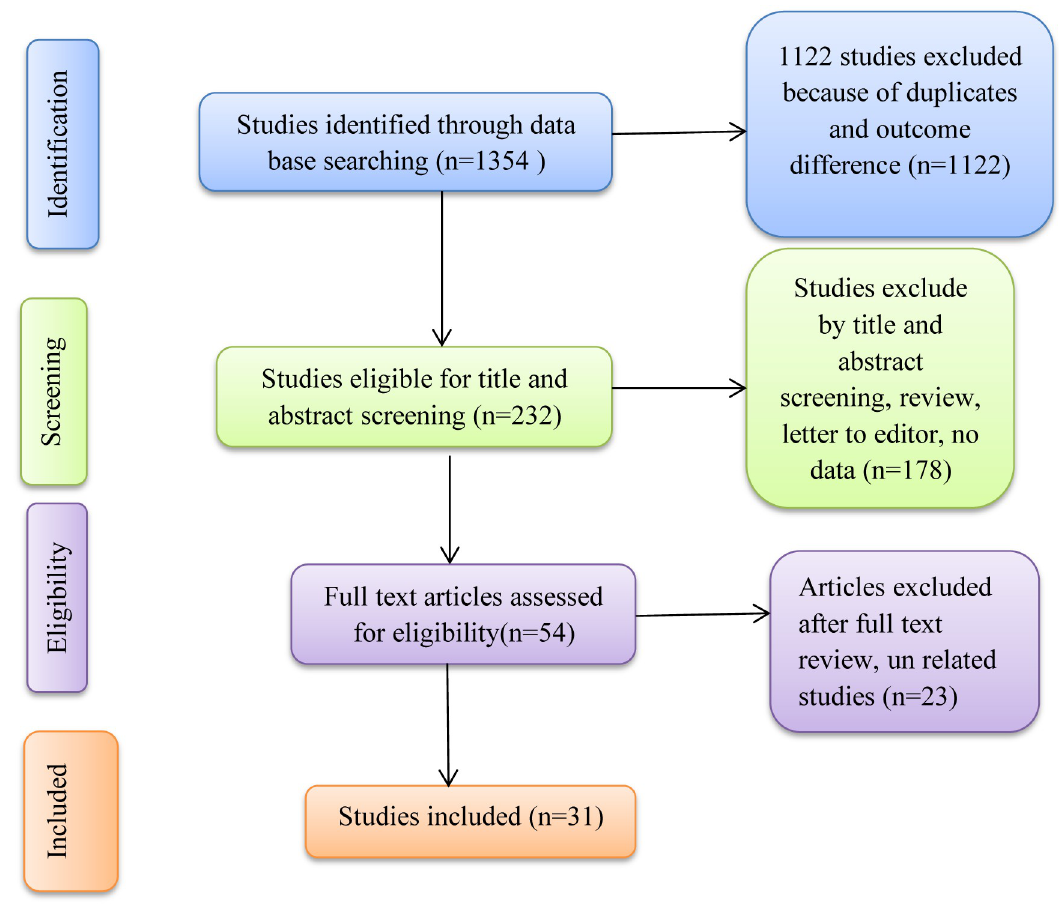
Fig 1. Flow diagram of systematic search of studies for this systematic review and